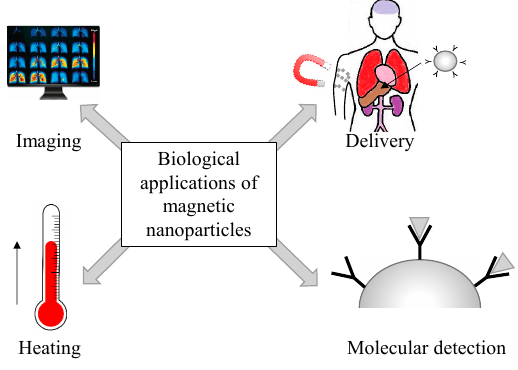
Figure 6. Overview of biological applications employing magnetic nanoparticles (adapted from [19]).